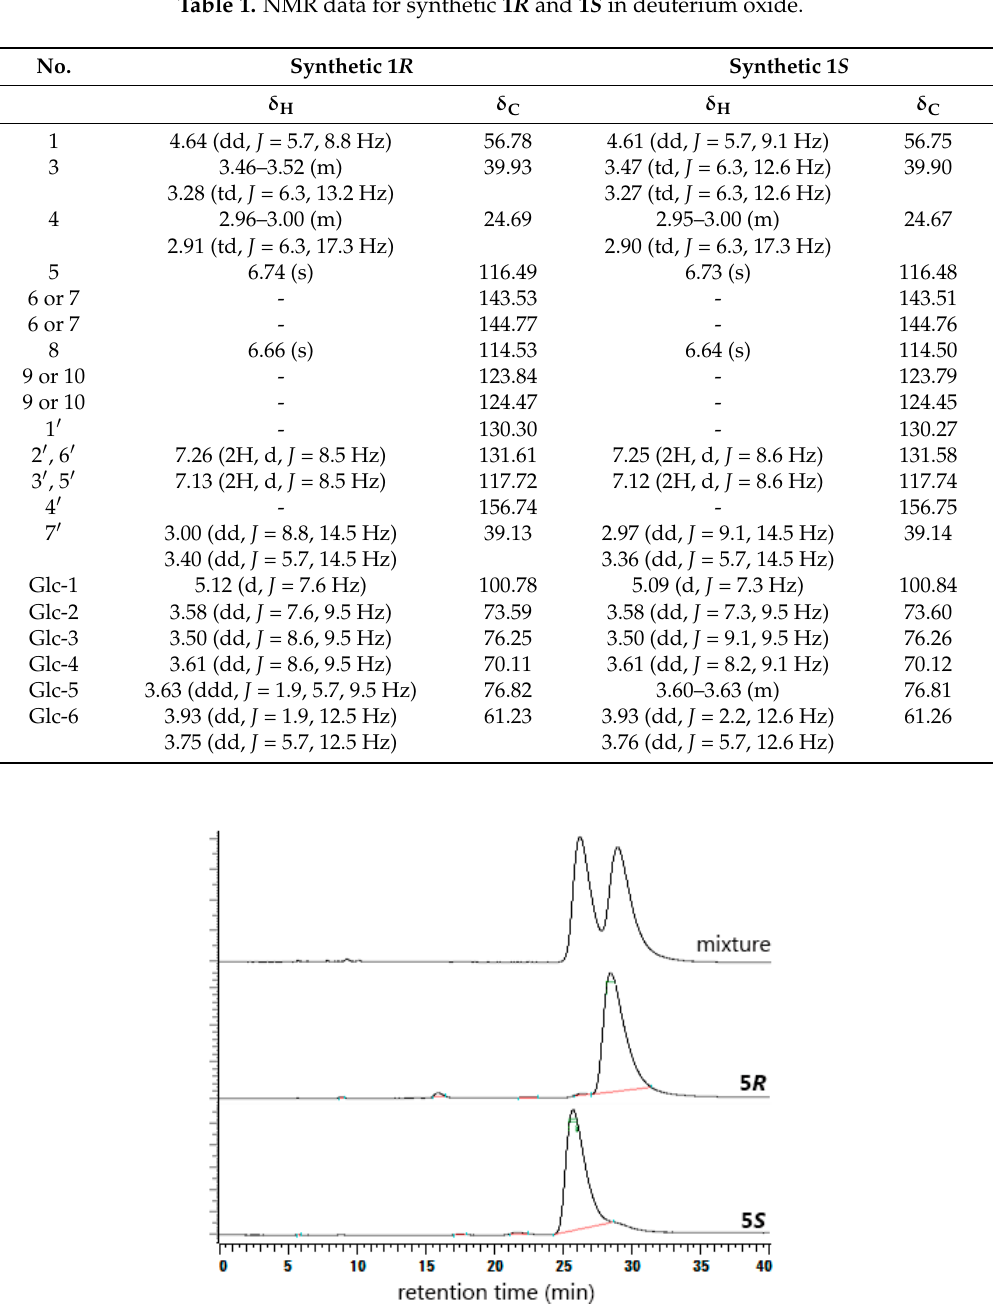
Figure 1. HPLC analysis of 5 R , 5 S , and their mixture. Conditions: column, Chiral CD-Ph (4.6 × 250 mm); mobile phase, 20 mM aq. KH 2 PO 4 /methanol = 50/50; flow rate, 0.5 mL/min; temperature, 40 °C; detection, 280 nm.